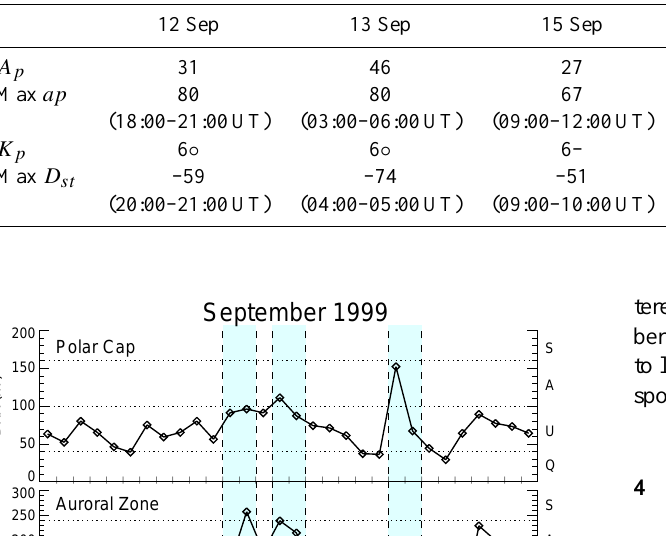
Table 1. Geomagnetic indices for the events